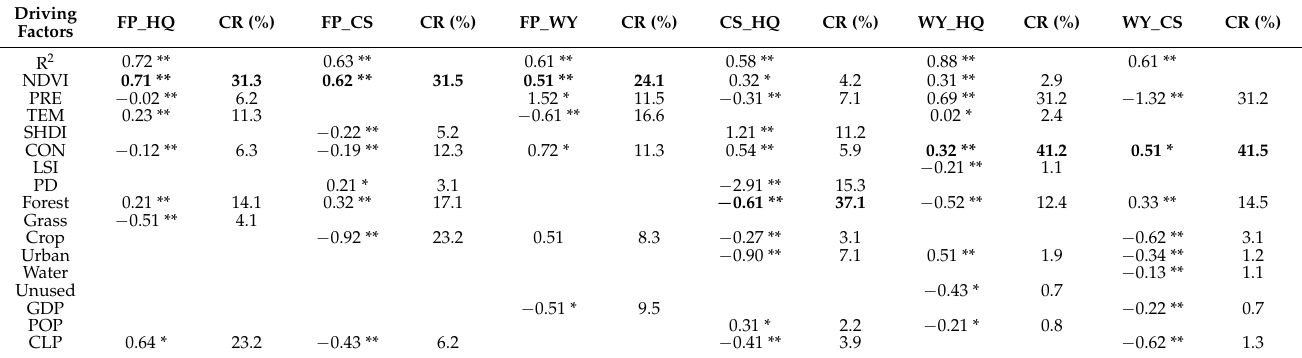
Table 6. Results of the 2020 automated linear modeling